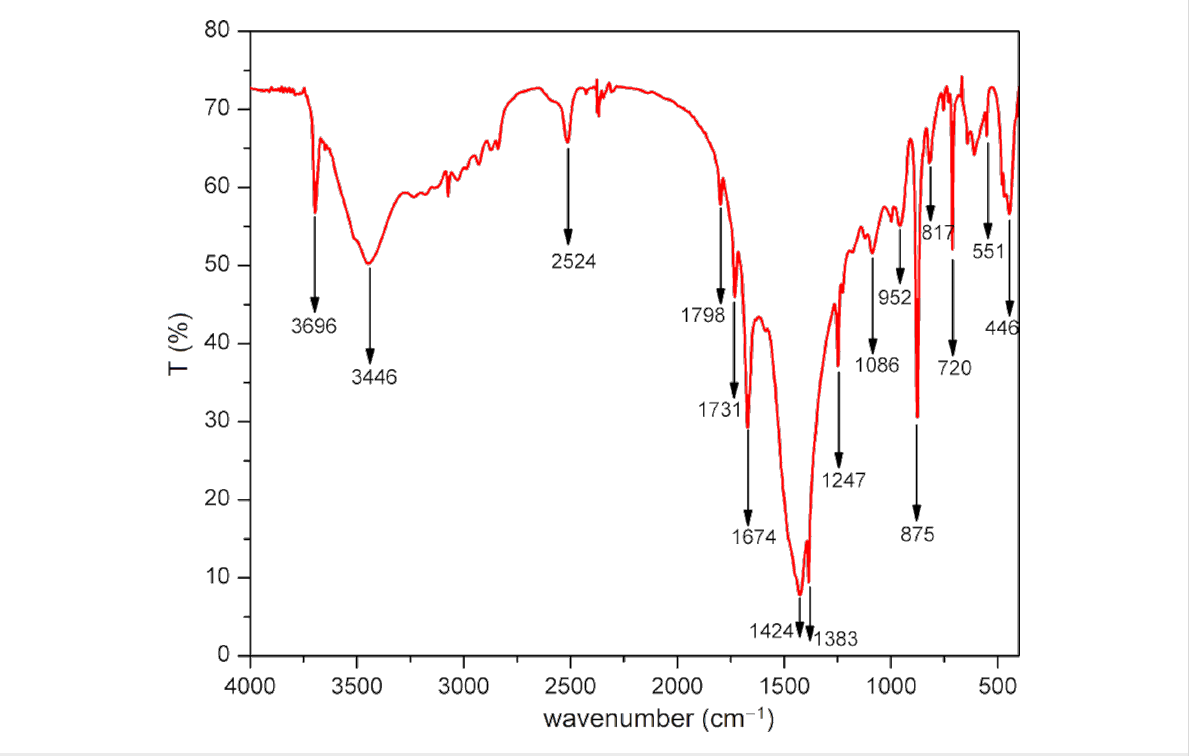
Figure 3: FTIR spectrum of the NDL catalyst.